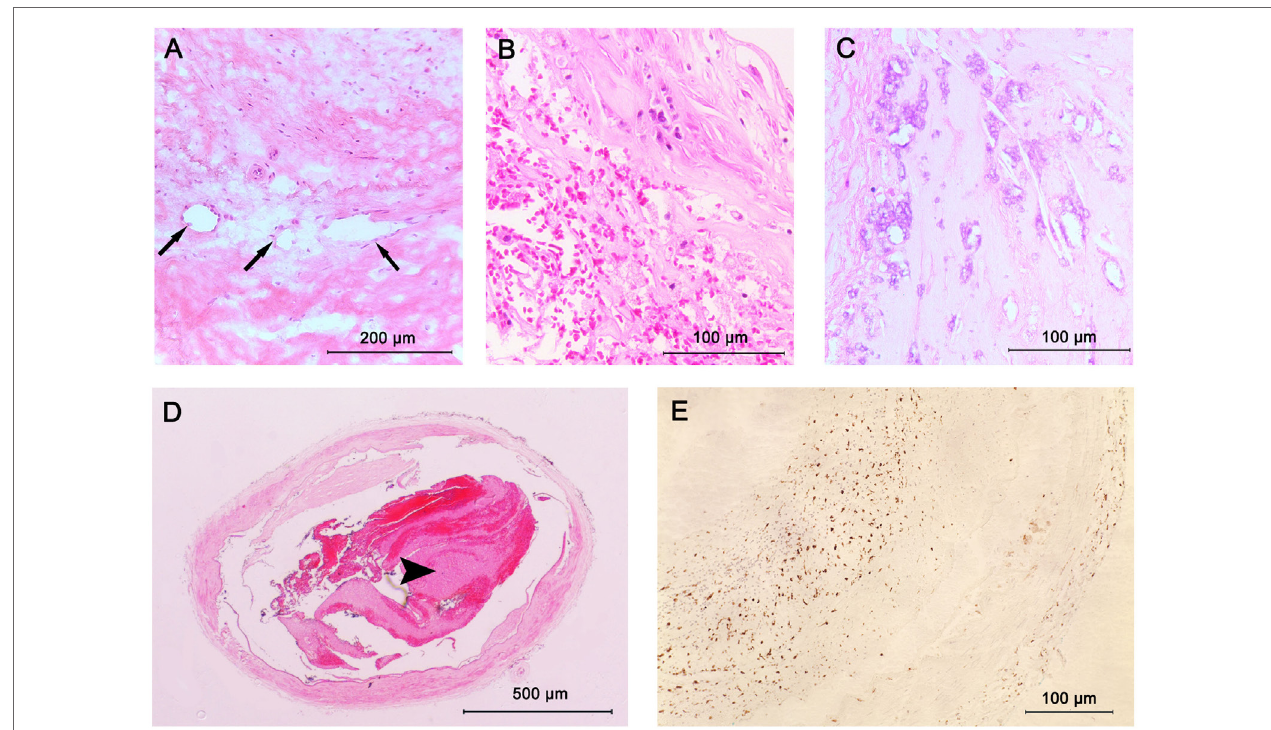
FigUre 3 | Plaque components in intracranial atherosclerosis. (a) Intraplaque neovasculature (arrows); (B) intraplaque hemorrhage; (c) large areas of calcification seen as purple morula; (D) lumen thrombus (arrowhead); stained with hematoxylin and eosin (H&E); (e) macrophage infiltration; stained with CD68